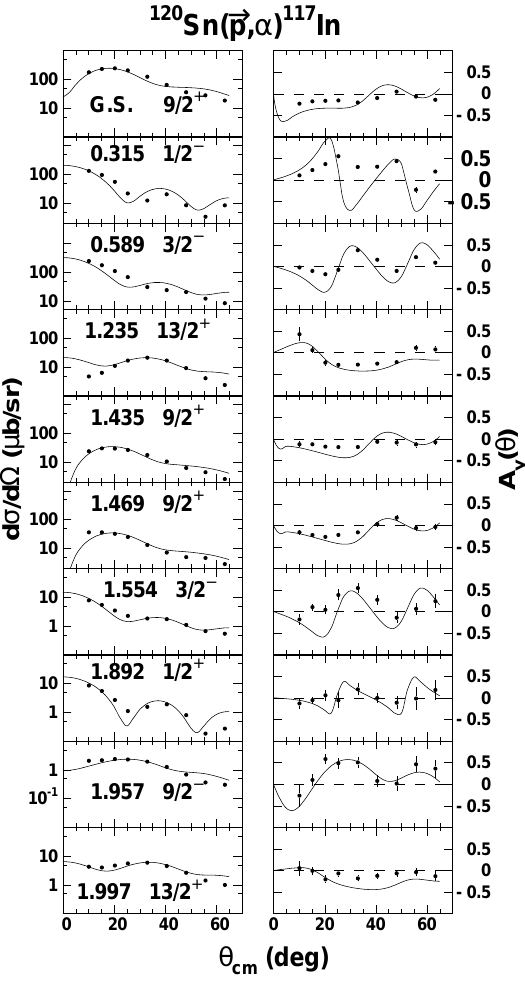
Fig. 3. Angular distributions of cross sections and asymmetries for some 117 In states populated in the 120 Sn( p , α ) 117 In reaction. Dots refer to the experimental values and solid lines to the cluster DWBA